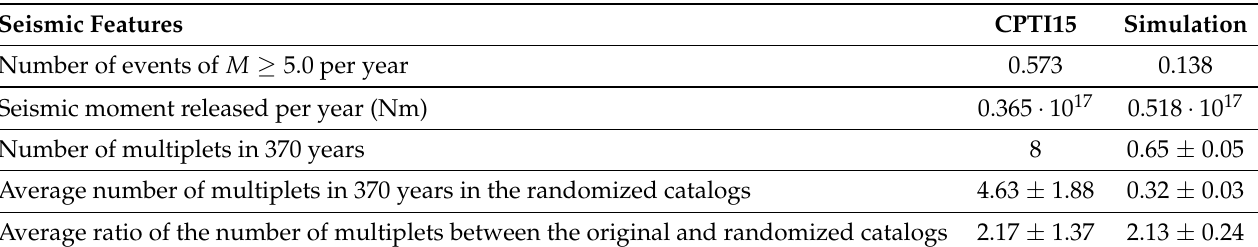
Table 5. A comparison of seismic features detected in CPTI15 1650–2020 catalog and 100,000 years simulated catalog (S–R = 0.2 and A–R = 10) for study